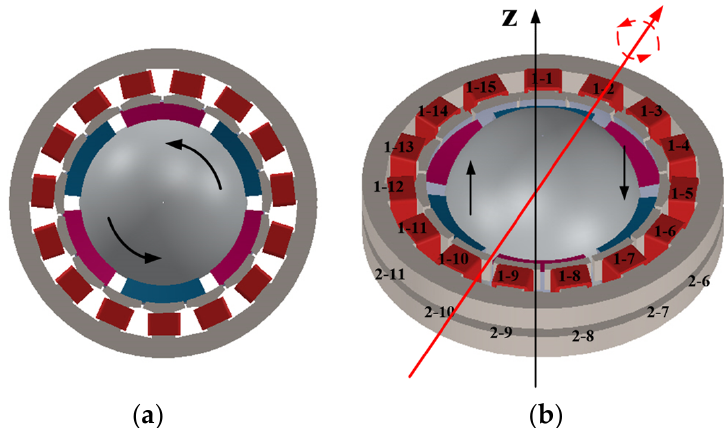
Figure 3. Electromagnetic driving principle: ( a ) Forward rotation; ( b ) Deflection.